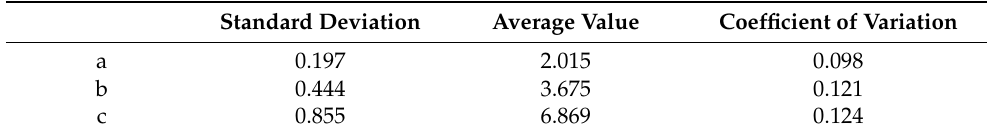
Table 5. The variability uniformity experiment of right five